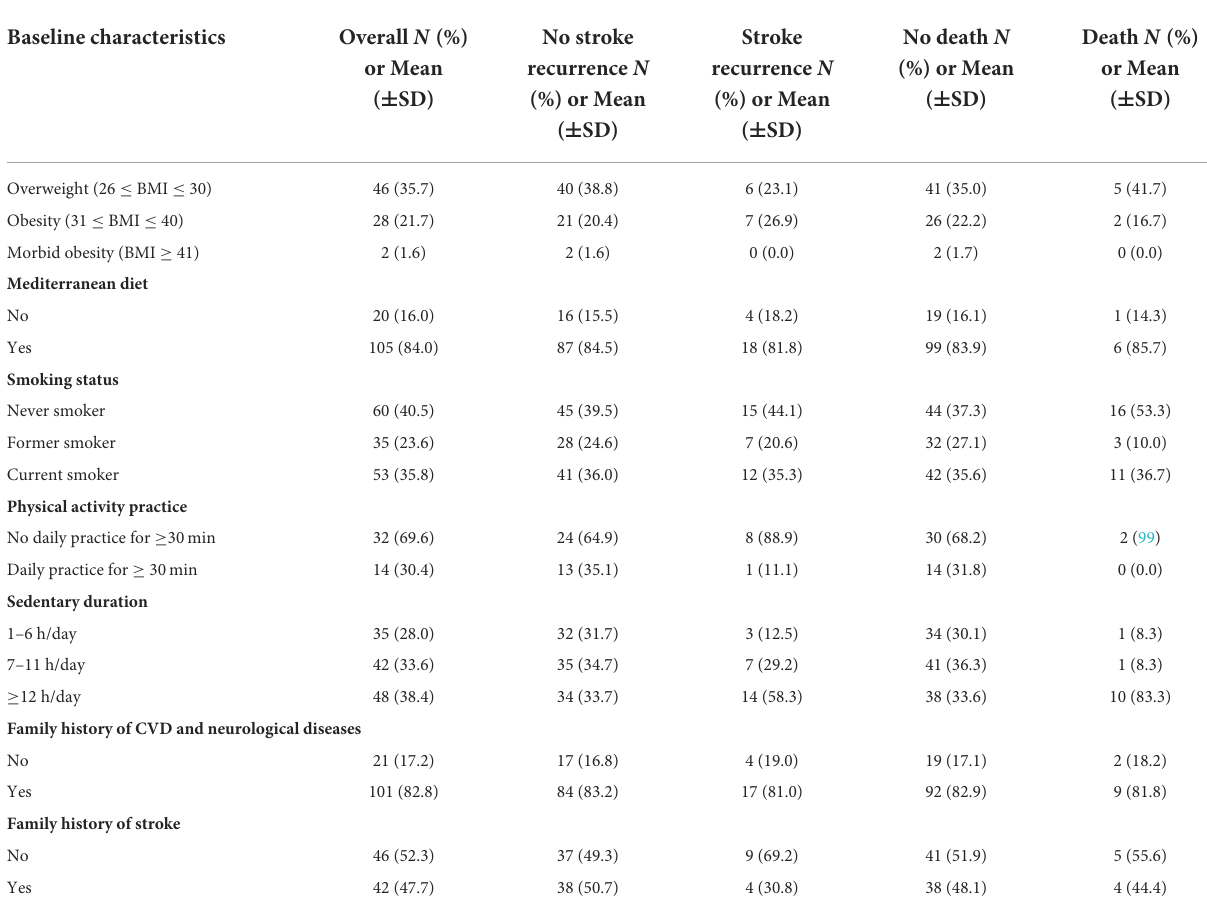
components of QoL (means between 28 and 40) at 3-, 6-, and 12-month follow-up periods. These levels were less than the theoretical averages (cut-off of 50 for PCS and 42 for MCS). At index admission, 47 (31.3%) subjects were already on antiplatelet and anticoagulation agents. At index discharge, these drugs were prescribed to 141 (94%) subjects.